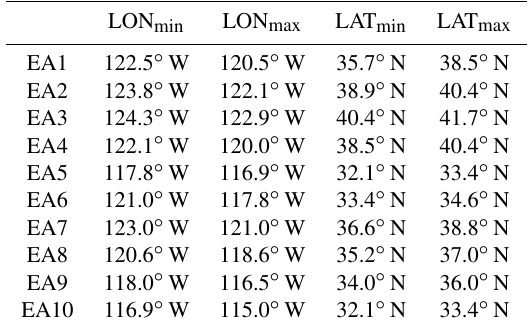
Table 4. Emission area coordinates. EA1–4 are used for BB totals and EA5–9 are used for anthropogenic